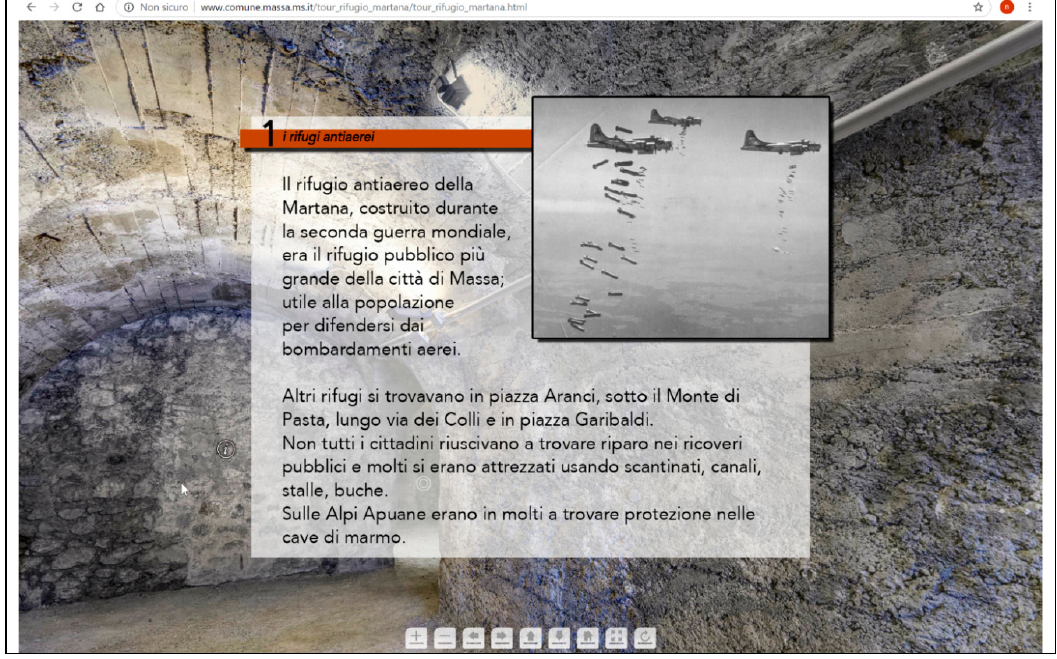
Figure A2: “Tour virtuale. Rifugio antiaereo della Martana ” (Massa). Command bar, link among scenes, hotspots, information window [23].